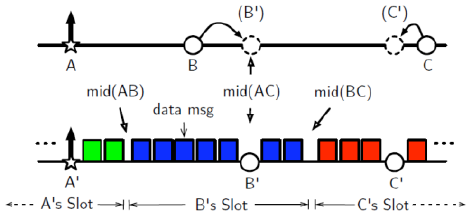
Figure 1. Adjusting its fire and assigning slot in the DESYNC- TDMA